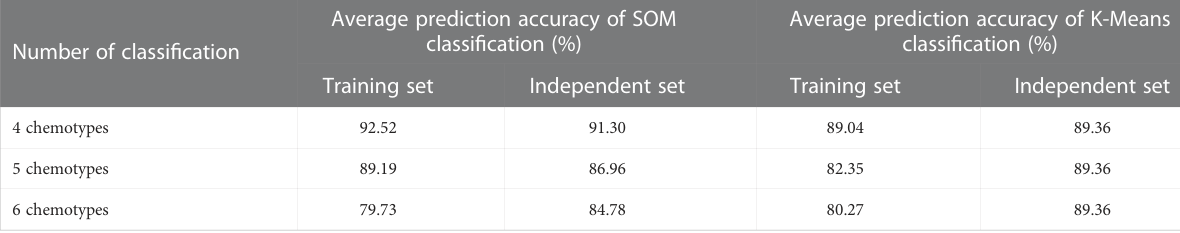
TABLE 1 Evaluation of the chemotypes classi fi ed by SOM and K-means by RF model.